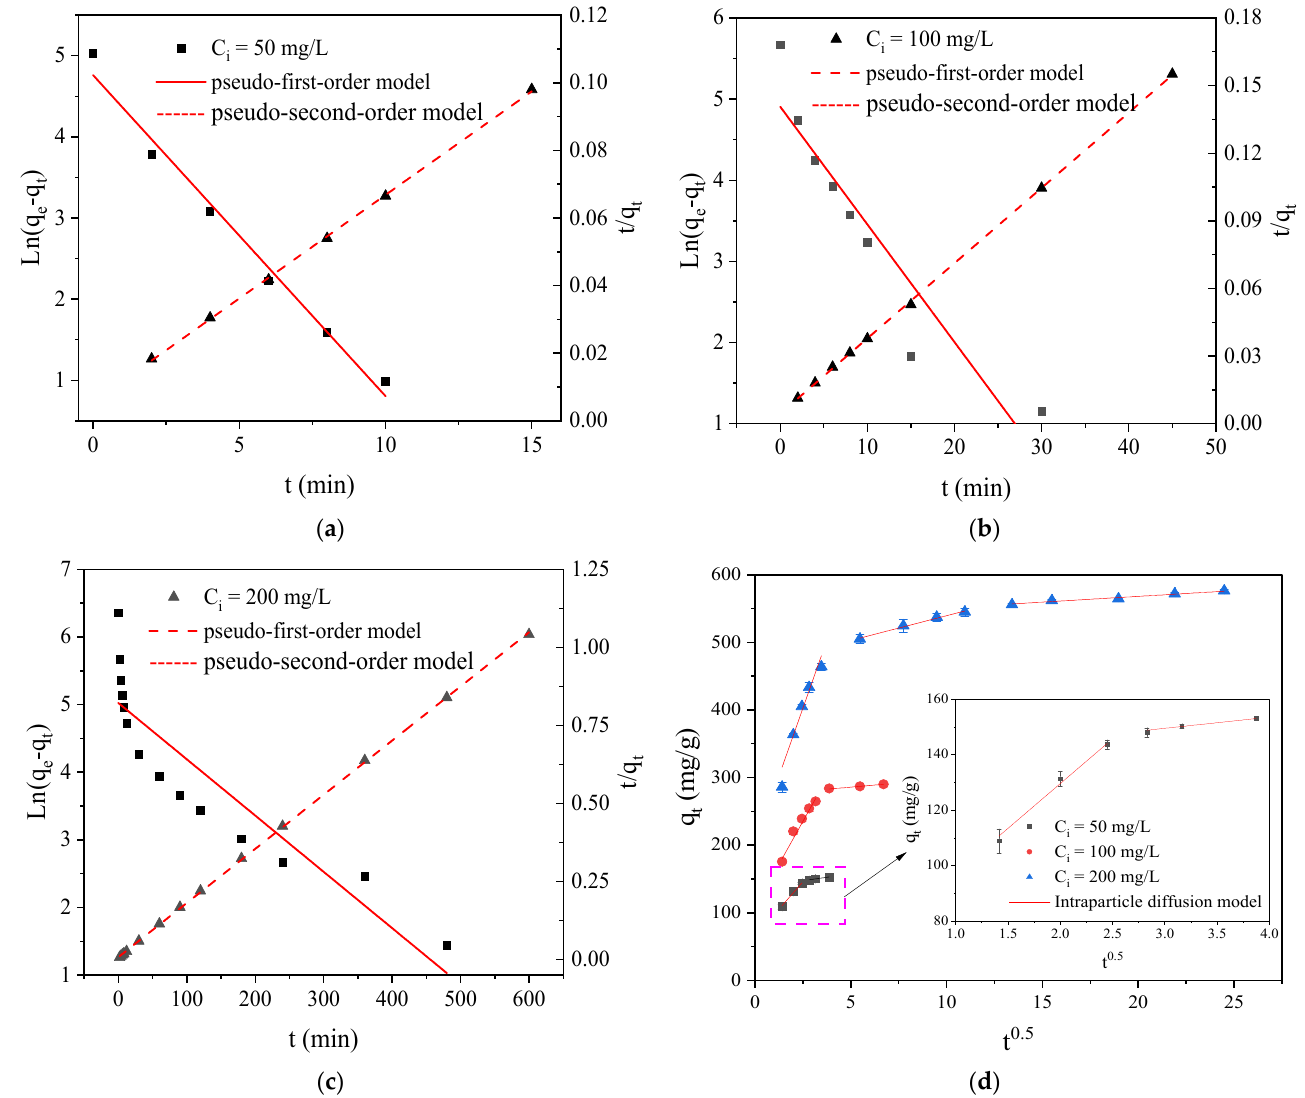
Figure 7. Pseudo-first/second-order modeling of RY2 adsorption on PEI/APTES-MWCNTs at an initial concentration of ( a ) 50, ( b ) 100, and ( c ) 200 mg/L, respectively; ( d ) intraparticle diffusion modeling of RY2 adsorption on PEI/APTES-MWCNTs.